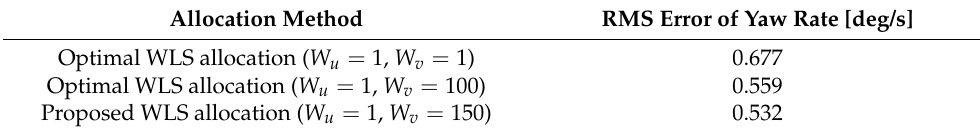
Table 3. Comparison of allocation methods (simulation